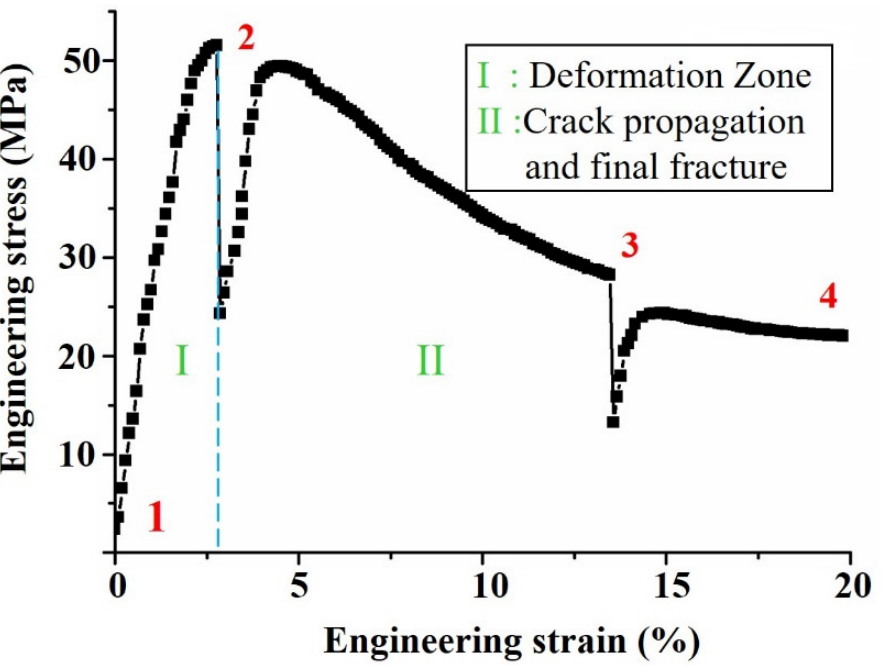
Figure 6. Engineering stress–strain curve of Cu/SAC305/Cu solder joint obtained by in situ tensile test. Positions 1, 2 and 3 represented the suspending points, and 4 represented the fracture point.